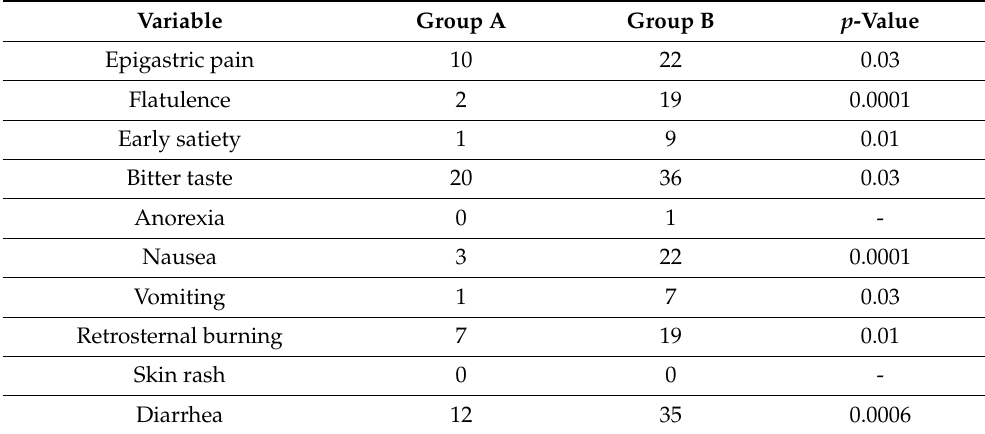
Table 3. Occurrence ofsymptoms as reported by patients in both groups during the administration of the eradication